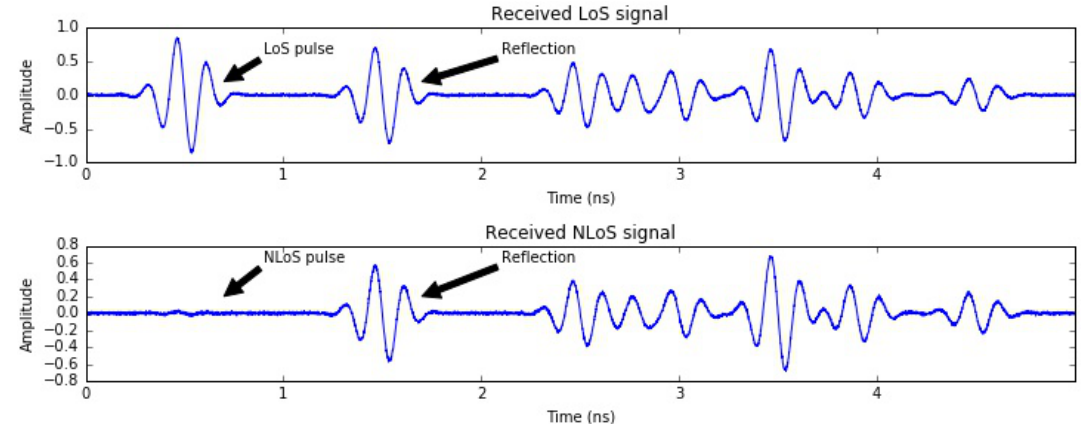
Figure 15. Received UWB pulses in LoS and NLoS